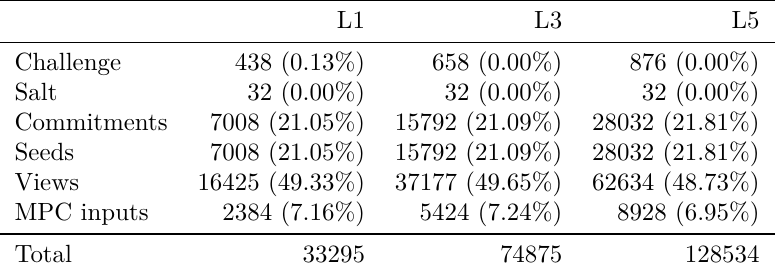
Table 10: Size breakdown of Picnic1 signatures, in